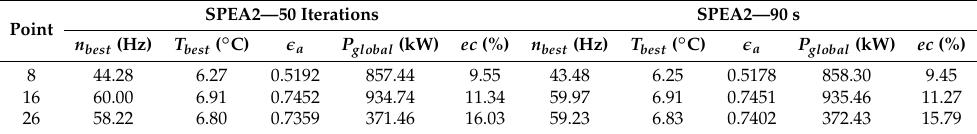
Table 4. Optimal solutions obtained by SPEA2 for the 4 operational points.